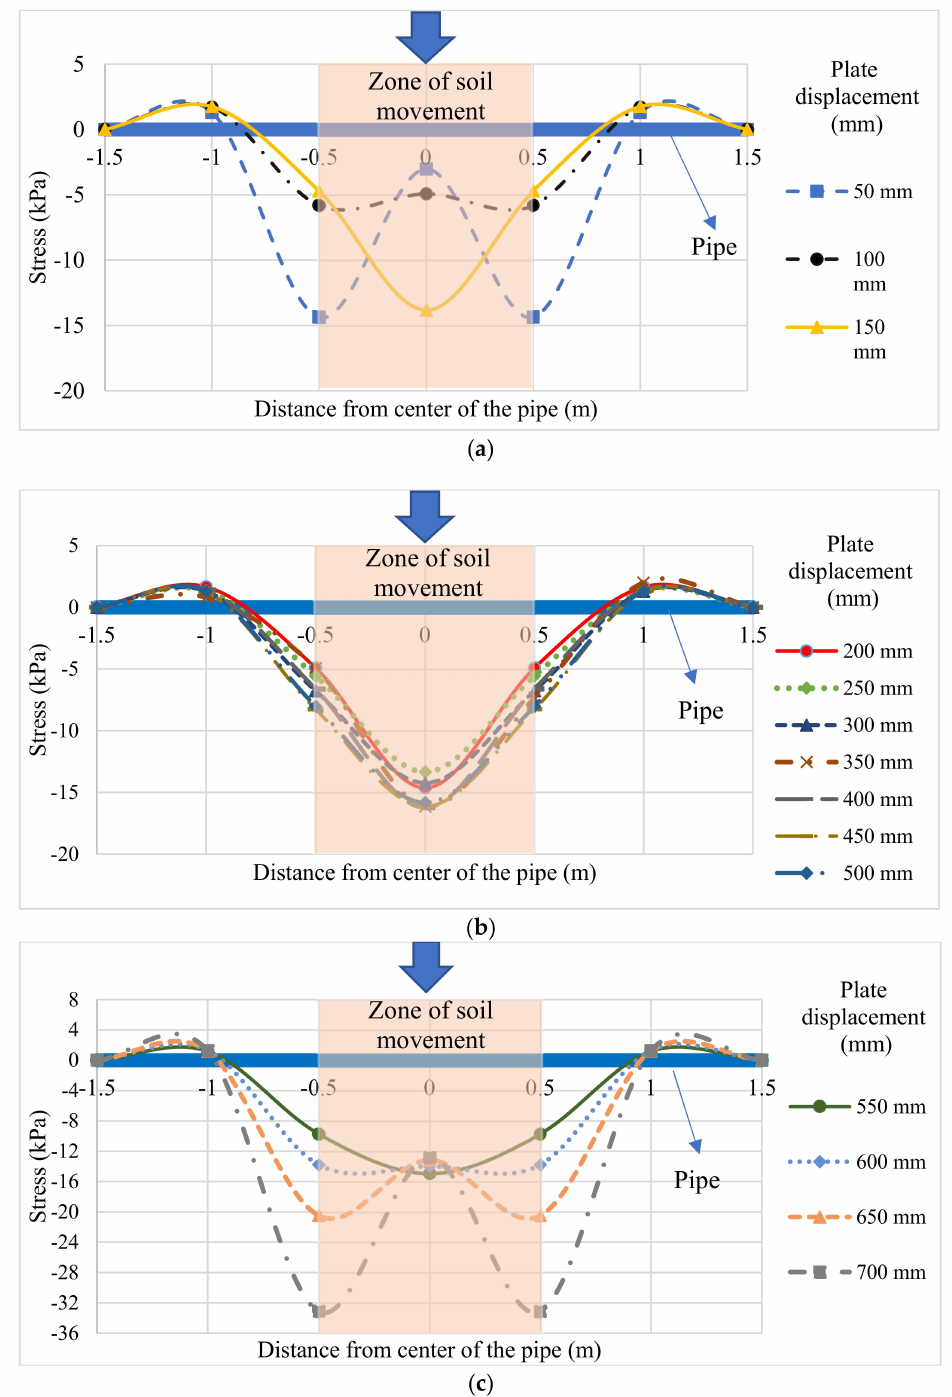
Figure 6. ( a ) Load distribution along the pipe at plate stages from 50 to 150 mm. ( b ) Load distribution along the pipe at plate stages from 200 to 500 mm. ( c ) Load distribution along the pipe at plate stages from 550 to 700